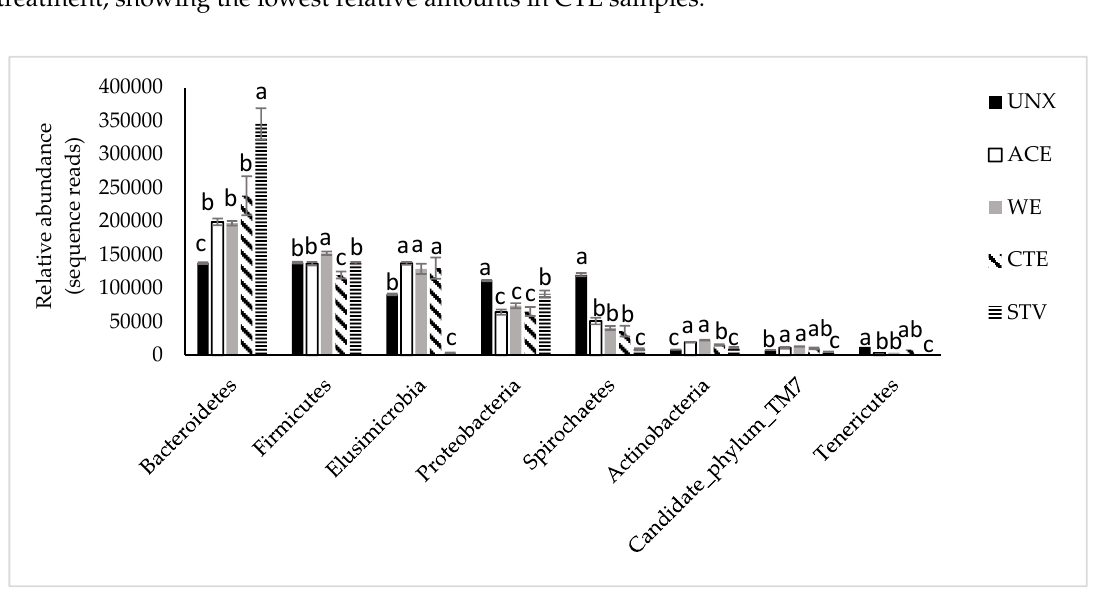
Figure 3. Effect of treatment on relative abundance of bacterial phyla. Bars represent means ± SE. Different letters above error bars within each phylum represent significant treatment differences, which were obtained by ANOVA followed by a multiple comparisons test corrected for false detection rate (FDR).